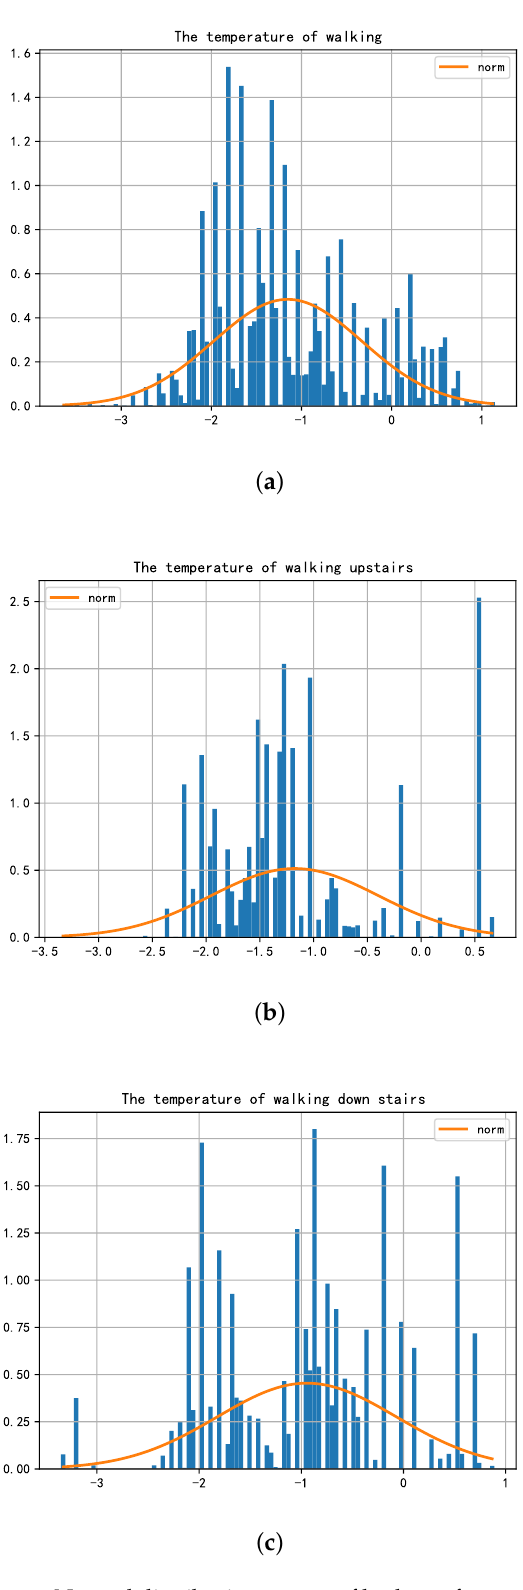
Figure 5. Normal distribution curves of body surface temperature error under dynamic activities. ( a ) The temperature while walking. ( b ) The temperature while walking upstairs. ( c ) The temperature while walking